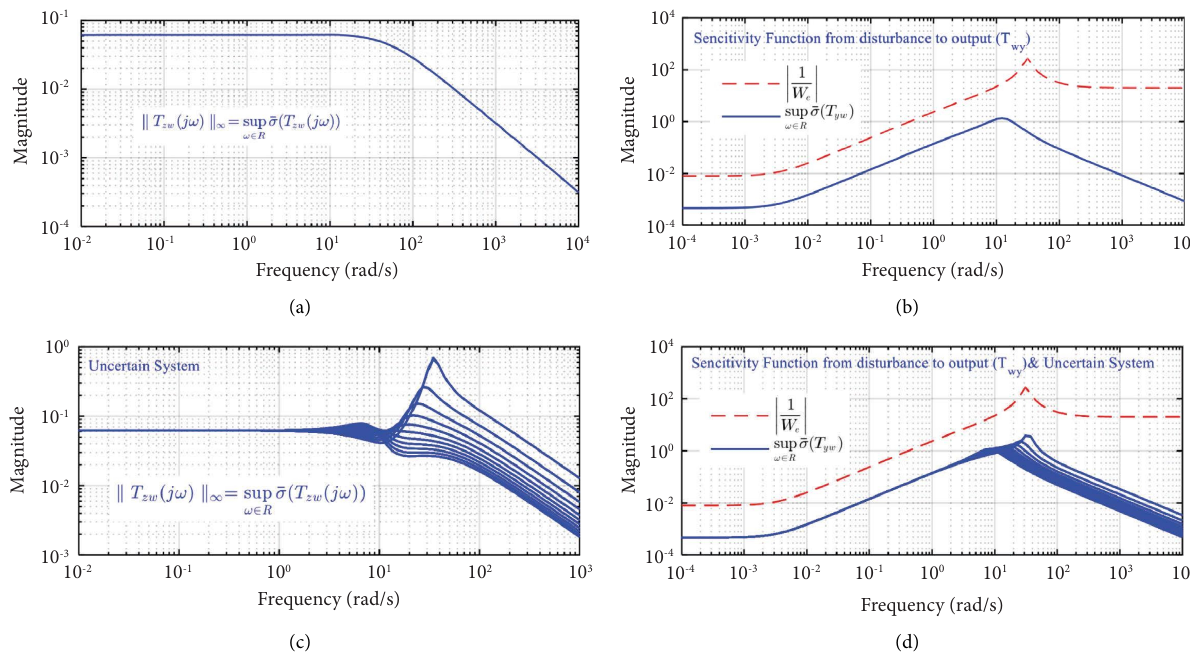
Figure 5: (a) NP index, (b) the sensitivity function from disturbance to T sensitivity function from disturbance to T